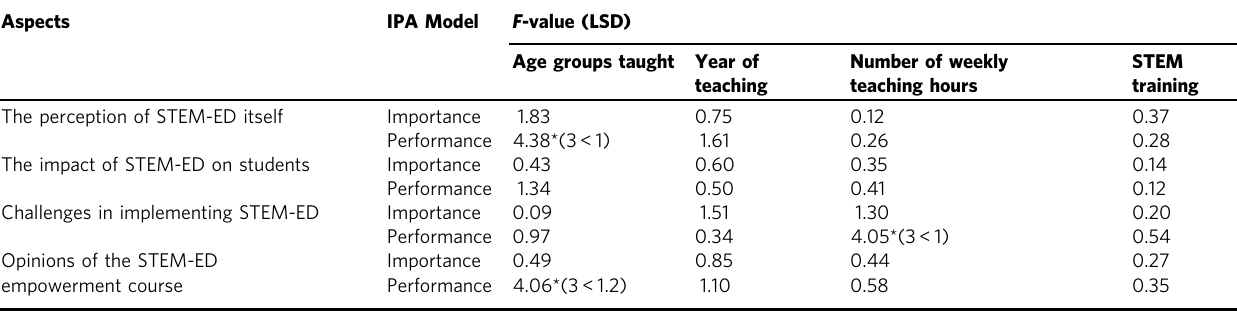
Table 4 Summary table of the analysis of